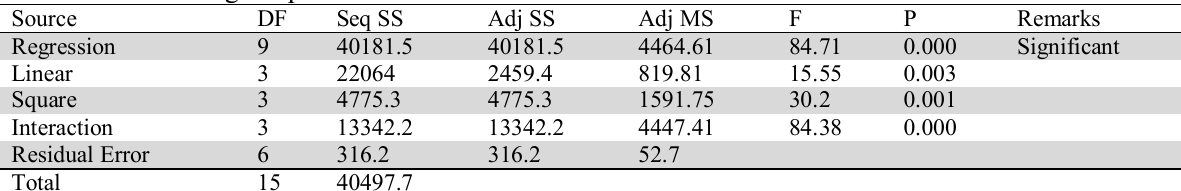
ANOVA for cutting temperature